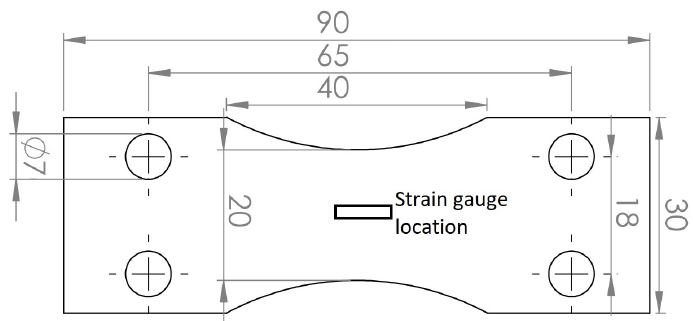
Figure 1. Specimen geometry in mm used for the bending fatigue tests.